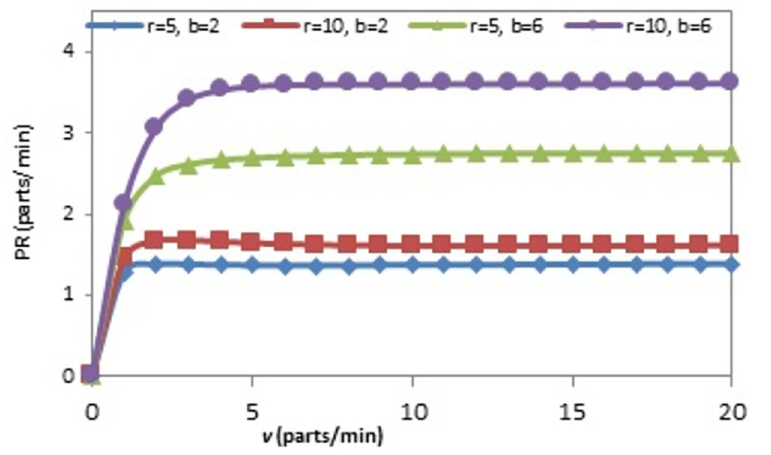
Fig 19. PR-v diagram for triple-machine FMC.